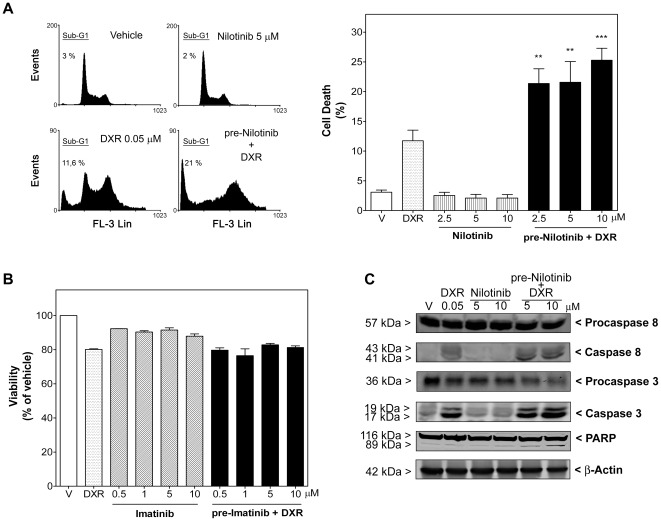
Combination of nilotinib, but not imatinib, with doxorubicin displayed a synergistic effect on apoptosis in leiomyosarcoma SK-UT-1 cells.A, left, DNA content of cells was measured by flow cytometry. Representative histograms of vehicle-treated (DMSO), DXR (0.05 µM)-treated, nilotinib (5 µM)-treated and pre-nilotinib 24 h+DXR-treated cells are shown. The fluorescence values used to calculate the peak corresponding to the sub-G1 phase are indicated on each histogram. Right, Columns show percentage of apoptotic cells in the absence (vehicle, V) or presence of DXR and nilotinib as single agents or combined (pre-Nilotinib+DXR). Each column represents mean ± SEM of four independent experiments. **
P<0.01 and ***
P<0.001 versus DXR-treated cells. B) Antiproliferative effect of imatinib as single compound or combined with DXR (0.05 µM) (pre-Imatinib+DXR) for 72 h. Each column represents mean ± SEM of three independent experiments. C) Panels show the immunoreactive bands of procaspase 8 and 3, cleaved caspase 8 and 3, and PARP fragmentation in representative immunoblots of leiomyosarcoma cells treated as in A.